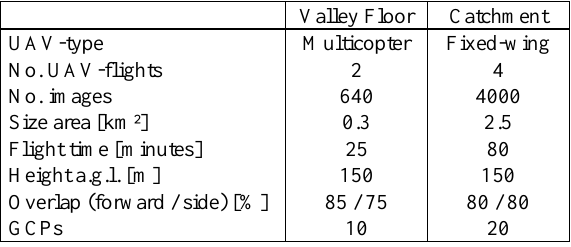
Table 1. Details of